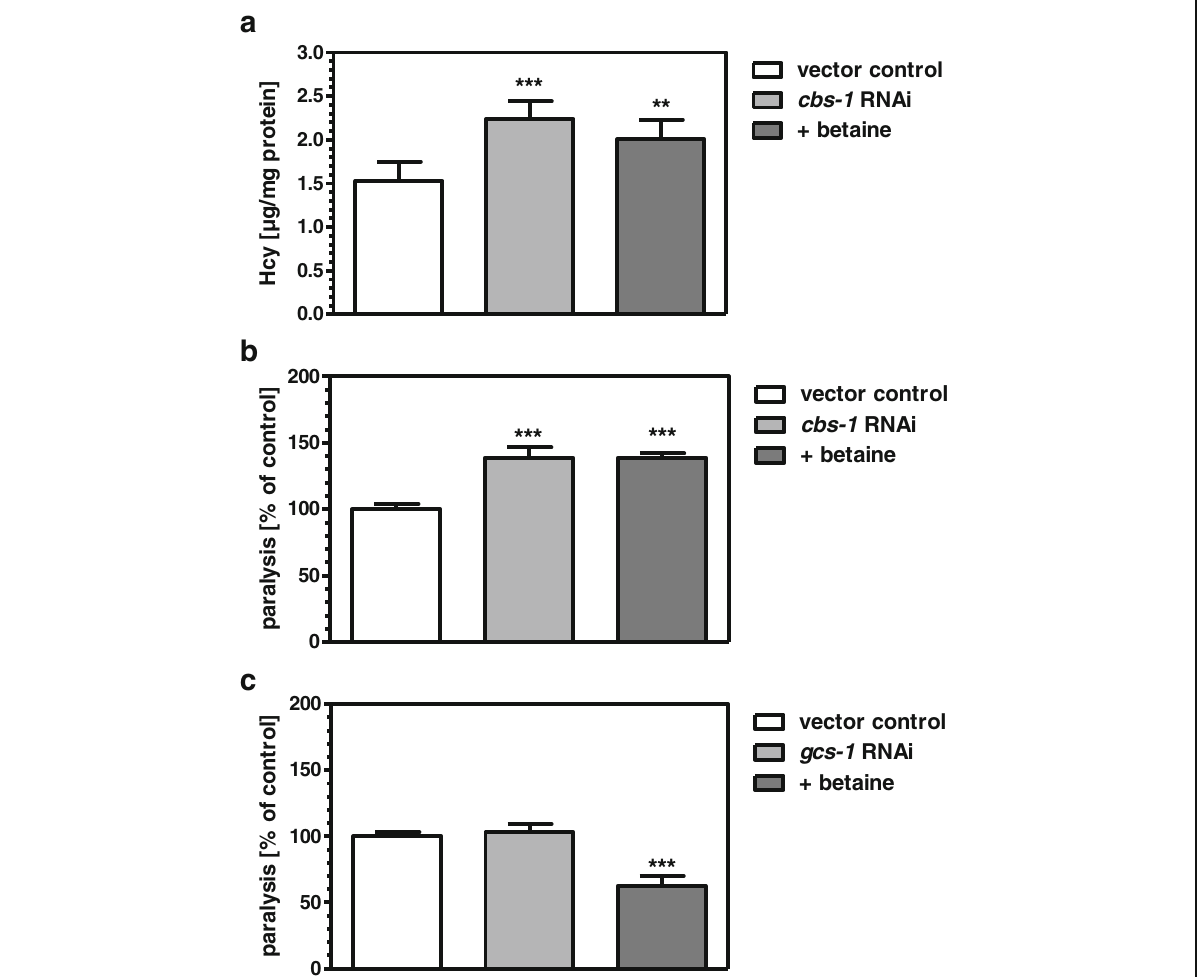
Fig. 3 The glutathione synthesis is not involved in the paralysis reducing effects of betaine. Under cbs-1 RNAi, betaine was no longer able to reduce Hcy level significantly ( a ) nor to diminish paralysis ( b ). Knockdown of gcs-1 , encoding the key enzyme for glutathione synthesis, did neither affect paralysis nor prevent the paralysis reducing effects of betaine ( c ). ** p <0.01, *** p <0.001 versus vector